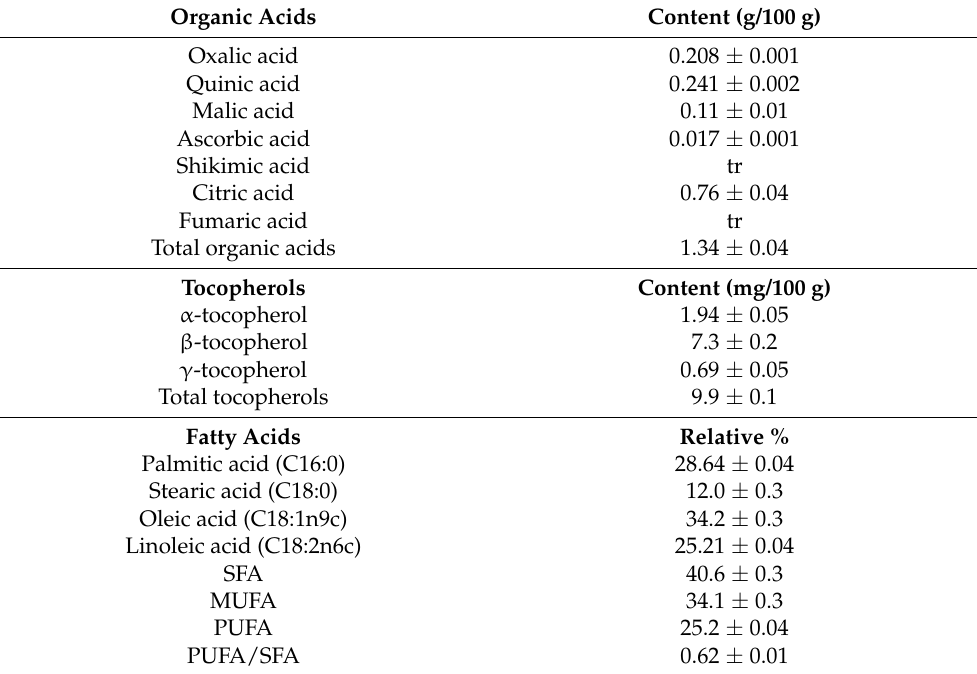
Table 1. The G. mangostana pericarp’s composition in terms of organic acids, tocopherols, and fatty